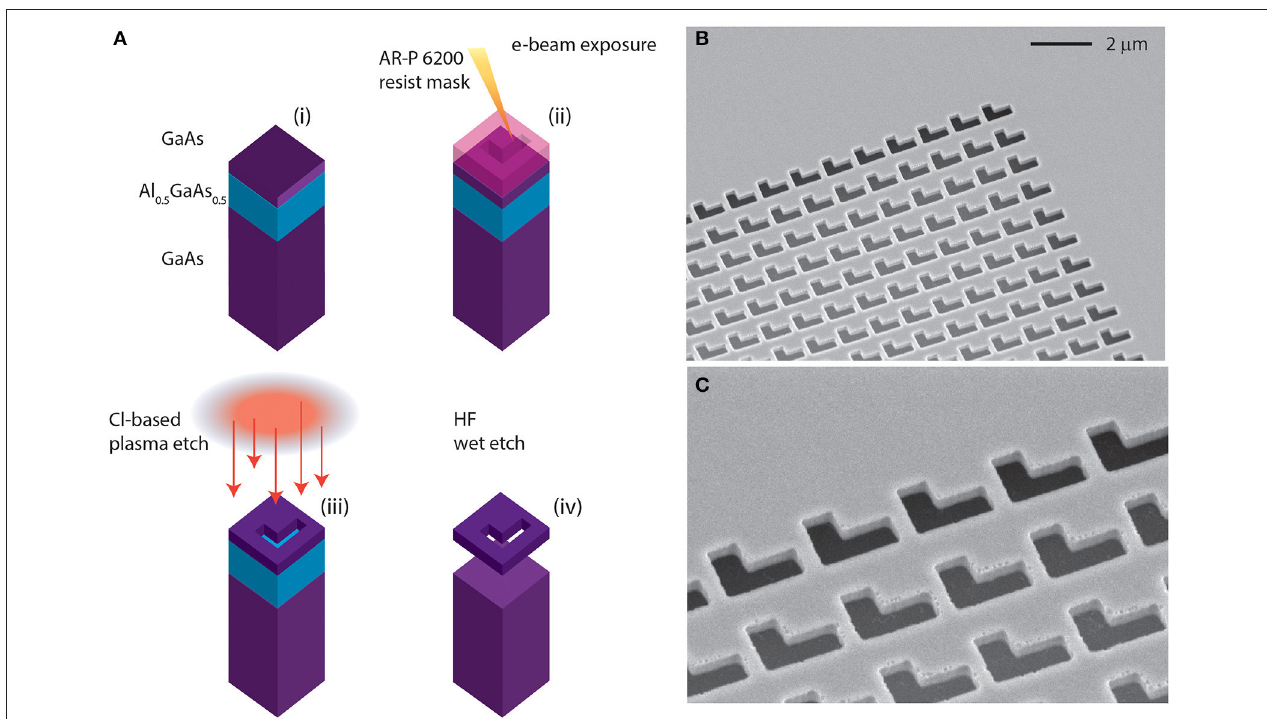
FIGURE 2 | (A) Fabrication steps. Starting from a GaAs/Al 0.5 GaAs 0.5 heterostructure (i), we spin-coat a layer of AR-P 6200 resist (ii). E-beam lithography is used to define the patterns, (iii) which are transferred on the device layer through a dry etching step (iv). Finally, the full structure gets released through HF wet etching. The